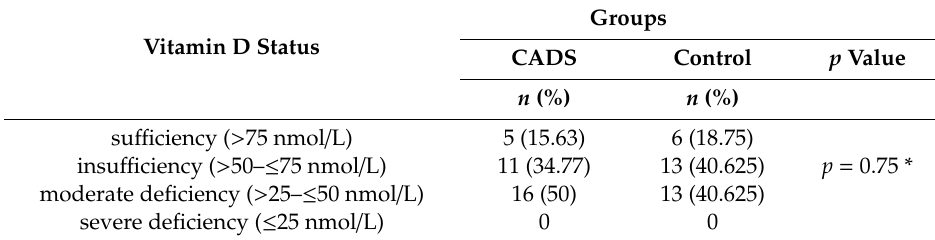
Table 4. Vitamin D status in Candida -associated denture stomatitis and control